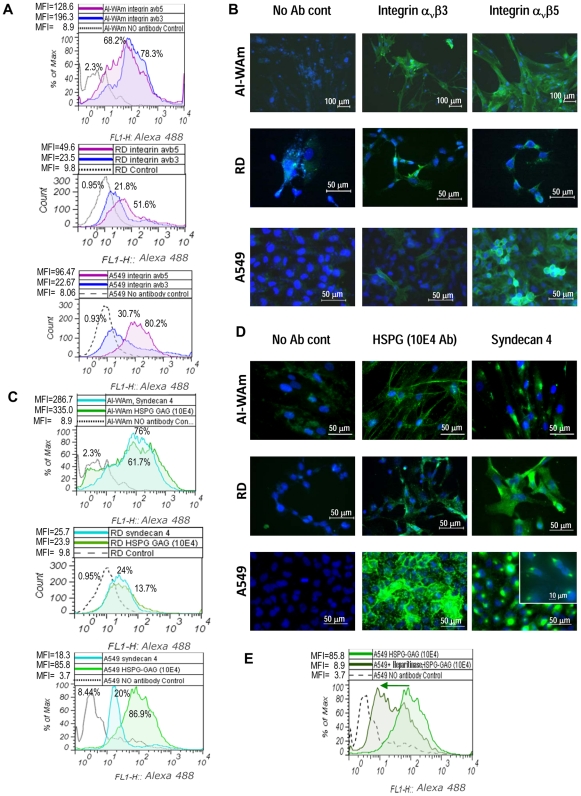
Expression analyses of HSPG and integrin molecules as alternate receptors for fiber-modified Ads on AI-WAm cells.Expression of αvβ3 and αvβ5 integrins (A and B) and heparin sulfate proteoglycans (C–E) in AI-WAm cell population and control cells was analyzed by flow cytometry (A, C, E) and IHC staining (B and D). Cells were incubated with primary anti-αvβ3 or anti-αvβ5 monoclonal antibodies for detection of corresponding integrin molecules or 10E4 antibody for detection of HSPG side chains (GAG) or anti-human syndecan 4 monoclonal antibody, followed by Alexa 488-conjugated secondary antibody. A and C, top charts: AI-WAm cells; middle charts: RD cells; bottom charts: A549 cells. For AI-WAm cells: P
(αvβ3/αvβ5) = 0.75; P
(Synd4/HSPG) = 0.29; For RD cells: P
(Synd4/HSPG) = 0.67; for αvβ3: P(RD/A549) = 0.38; for αvβ5: P(AI-WAm/A549) = 0.23; for syndecan 4: P
(RD/A549) = 0.2; for all other differences P<0.05; E. HSPG Ab (10E4) specificity control sample: A549 cells were treated with heparitinase (10 U/ml) for 1 hr at 37°C to remove GAG side chains. Green arrow shows shift of the fluorescence intensity peak resulting from reduction in cell labeling with 10E4 antibody (MFI decrease). Other details are as in
Fig. 2D
. B and D, scale bars correspond to: 100 µm in top image panels (integrins/AI-WAm, 10× objective), 10 µm (insert, 60× objective) and 50 µm (40× objective) in all other panels. Insert shows syndecan 4 staining image (60×) of A549 cells, clearly demonstrating a polarized intracellular localization of the protein.